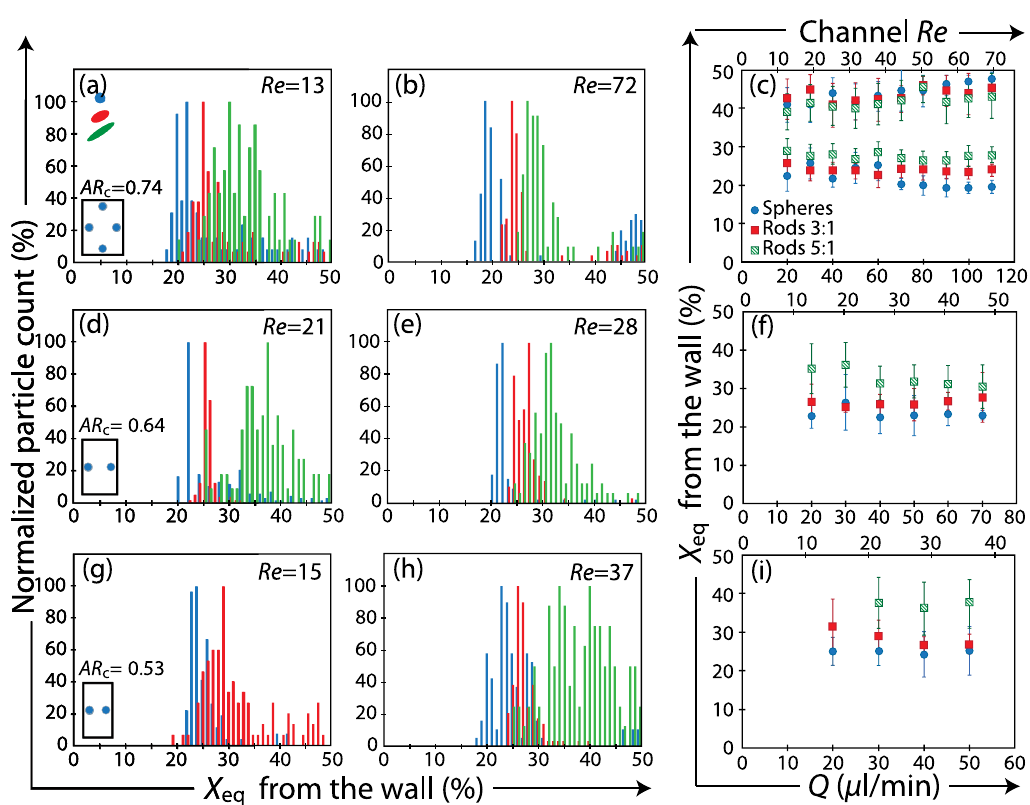
FIG. 3. Focusing distributions depend on particle shape, channel aspect ratio ( AR for spheres, 1:3 rods, and 1:5 rods, in different channel cross sections and at different flow rates, indicate (e),(g),(h) Histograms of X eq that equilibrium positions vary for different shapes. (a),(b) AR ¼ 0 : 64 , and Q ¼ 30 and 40 (cid:1) L = min , respectively; (g),(h) AR (e) AR c is plotted for all channel geometries and flow conditions tested, with error bars indicating the standard deviation (i) Averaged X eq obtained from at least 100